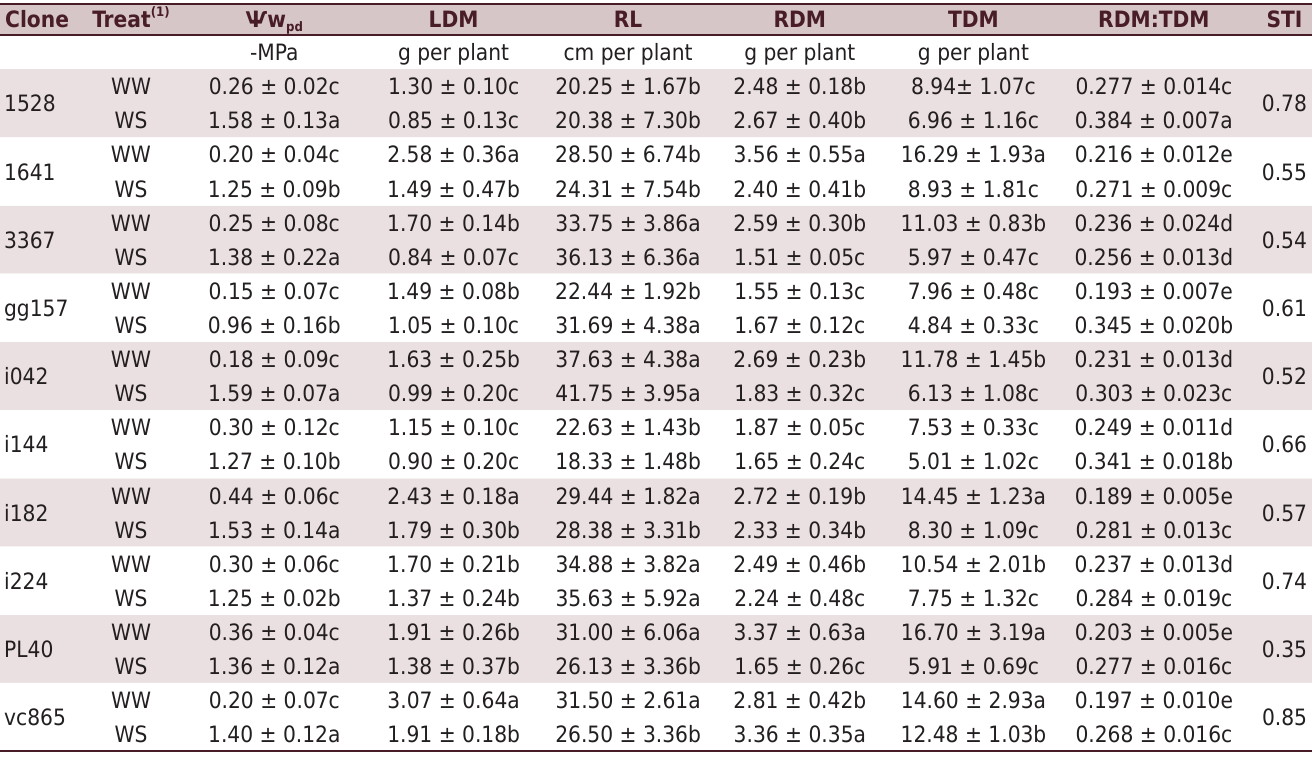
Table 1. Predawn water potential (Ѱw pd ), leaf dry matter (LDM), root length (RL), root dry matter (RDM), total dry matter (TDM), root:shoot ratio (RDM:TDM), and Stress Tolerance Index (STI) of ten Eucalyptus clones under well-watered (WW) or water stress (WS) conditions. Data indicate the mean ± SE (n =4). Means followed by the same letter in a column did not differ significantly by the Scott Knott test (p ≥ 0.05) Clone Treat